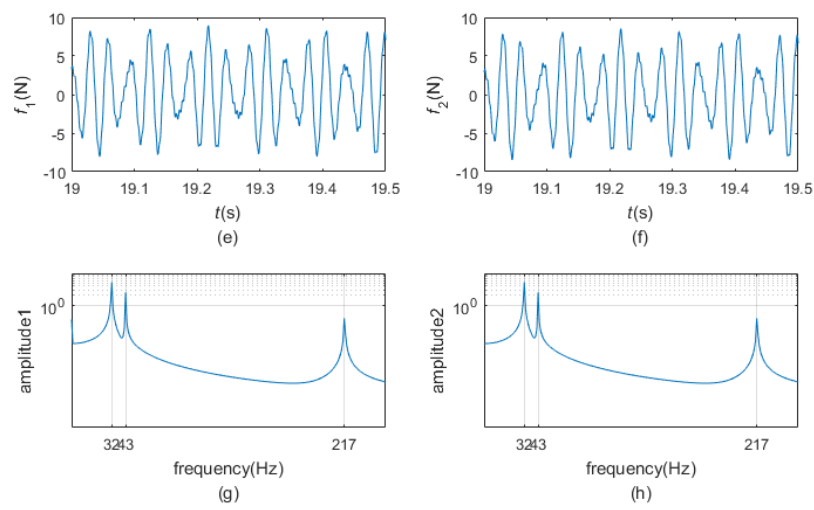
Figure 17. The normal contact forces and friction forces versus time t curves ( a , b , e , f ); and frequency spectrums of the normal contact forces ( c , d,g,h ).